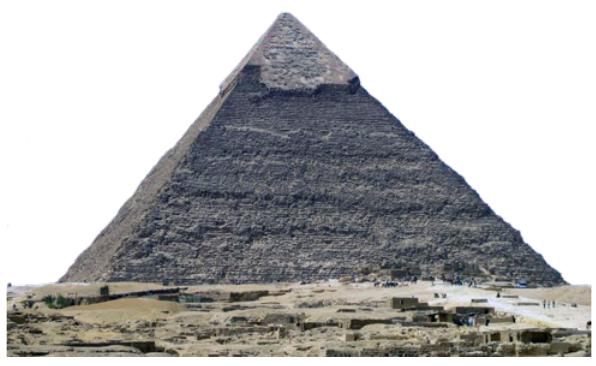
Figure 1. The Kephren Pyramid in which gypsum mortar was used.